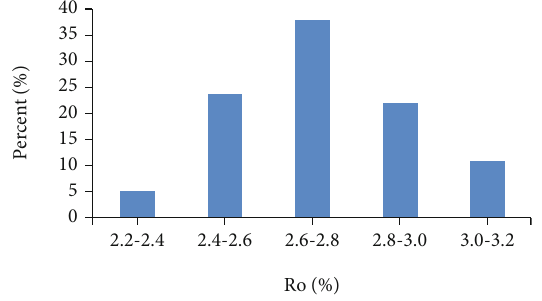
Figure 8: Equivalent vitrinite re fl ectance distribution of the Wufeng-Longmaxi Formation shale in the southeast Sichuan